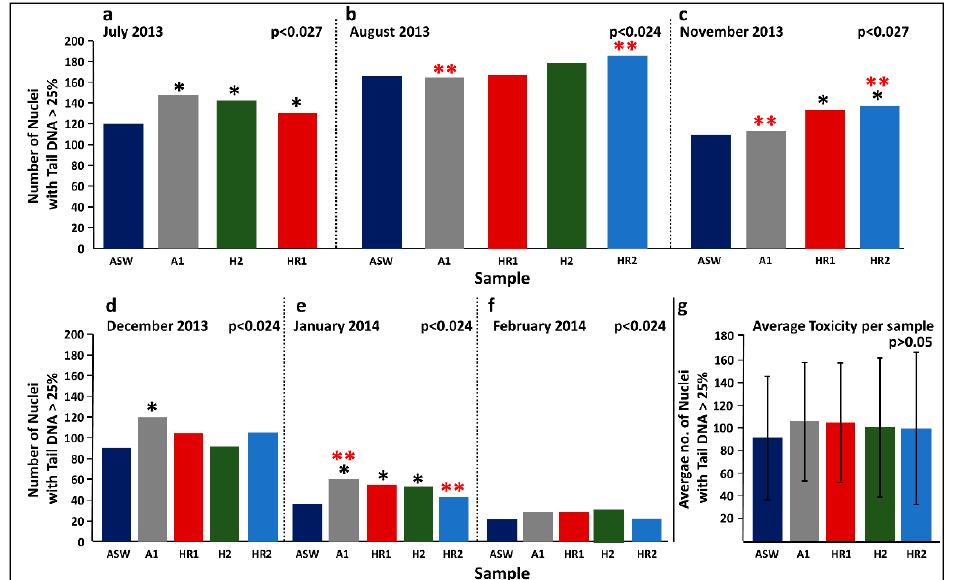
Figure 6. Genotoxicity tested on samples taken near the Hadera desalination plant outflow. The p -value is indicated for each set of experiments. ( a – f ) Genotoxicity levels for each indicated month. A Chi-square test was performed, comparing the number of nuclei with more than 25% tail DNA be- tween the various sites and controls. In total, 300 nuclei were analyzed per site/treatment. Significant differences: *—significant result relative to ASW control; **—field sample vs. other field samples. ( g ) The average genotoxicity at the various sites along the tested period. The error bars represent the standard deviation. A repeated measures ANOVA analysis was used to test for significant differences between sites, but no significant differences were detected ( p > 0.05).